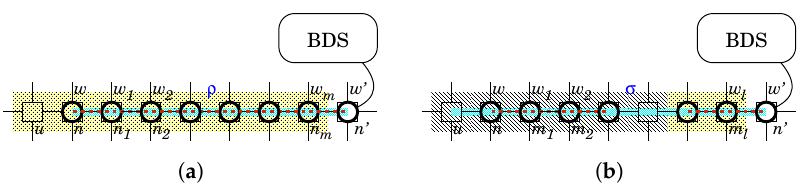
Figure 6. Illustration of Property 2 and Corollary 1. ( a ) “If” part; ( b ) “Only if”